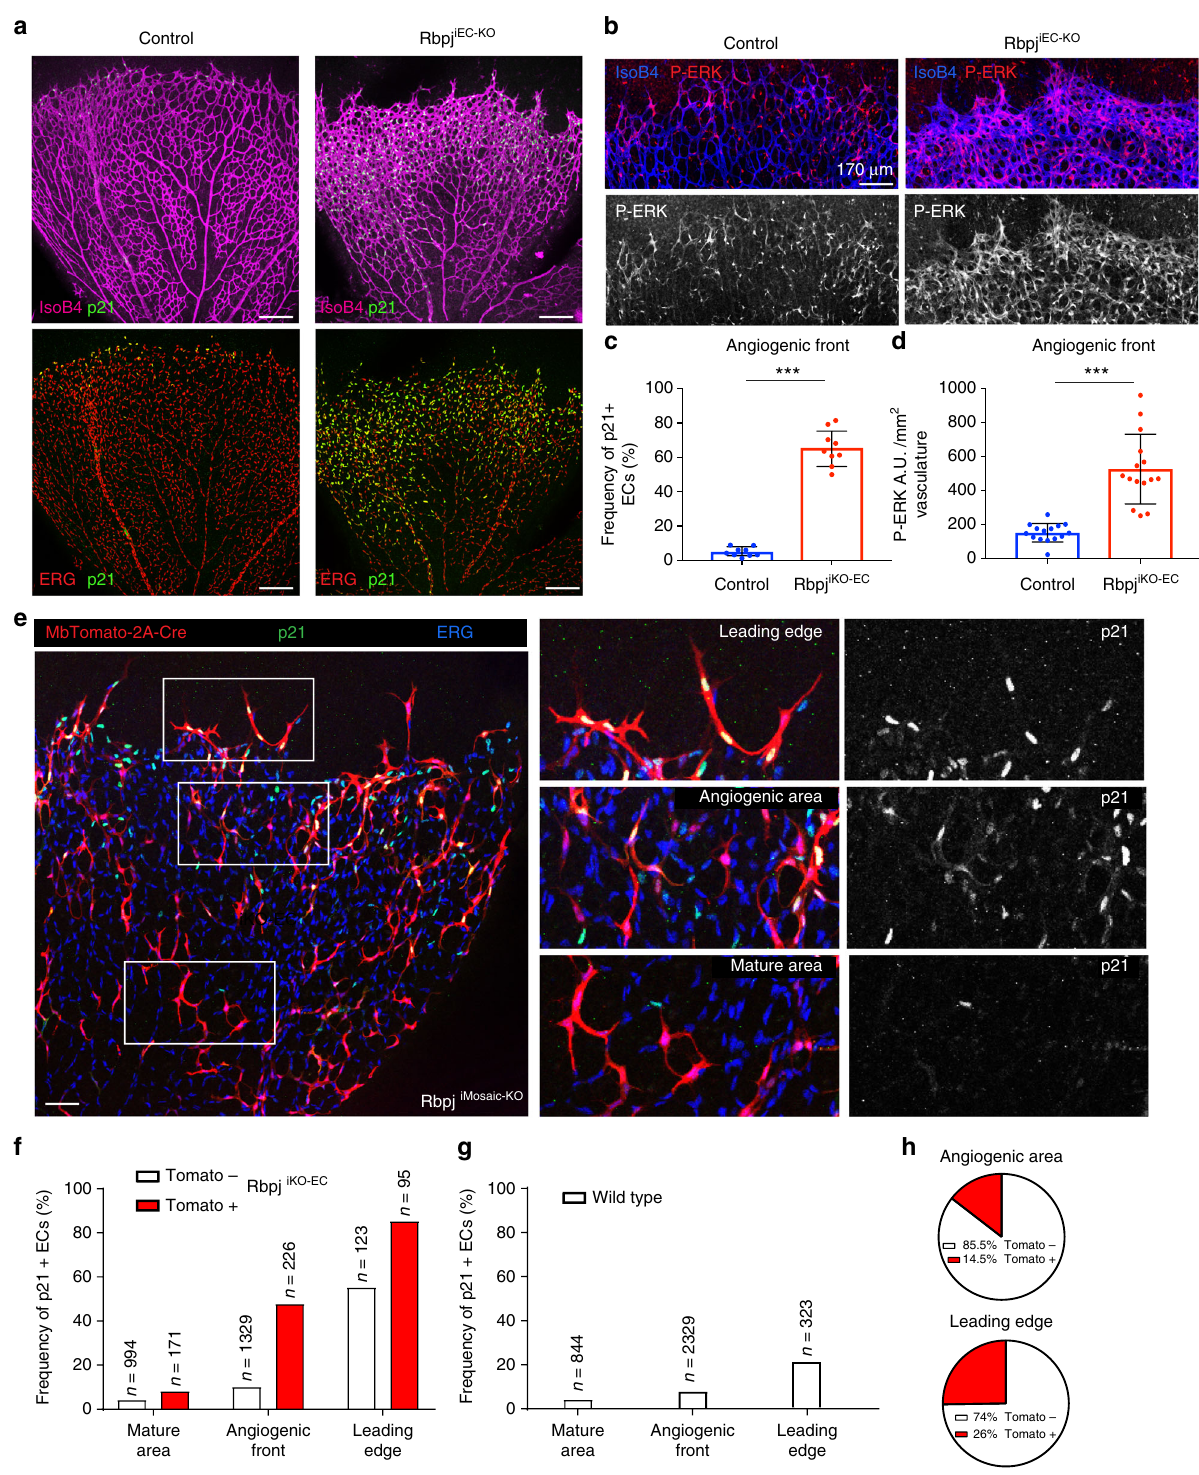
Fig. 5 Individual ECs with loss of Rbpj/Notch signalling often express p21 and occupy the leading edge. a – d The induction of Rbpj genetic deletion from P1 to P3 results in a strong increase of p21 and P-ERK levels at the AF in P6 retinas. Charts show quanti fi cation of several large microscopic fi elds ( n = 3 mice per group). Scale bars, 200 μ m. e Confocal micrographs of P6 retinas from animals with inducible mosaic deletion of Rbpj in ECs ( Rbpj iECMosaic-KO ) expressing MbTomato-2A-Cre. Images to the right are high-magni fi cation views of boxed areas, showing the indicated signals in more detail. Scale bar, 115 μ m. f , g Quanti fi cation of mutant (Tomato + ) and control (Tomato − ) ECs (ERG + ) from Rbpj iECMosaic-KO retinas ( n = 6). Individual cells without Rbpj/ Notch signalling (MbTomato-2A-Cre + ) are more frequently p21 + , especially if they are at the leading edge of retina vessels. In the mature vascular area, most ECs with Rbpj deletion do not upregulate p21. Note that a fraction of Tomato − cells may have Rbpj deletion (compare white bars in f with g ). h Cells without Rbpj/Notch signalling (MbTomato-2A-Cre + ), are more frequently found at the leading edge of vessels than at the angiogenic front. Error bars indicate std. dev; *** p < 0.0005. Two-tailed unpaired t test. Source data are provided as a Source Data fi